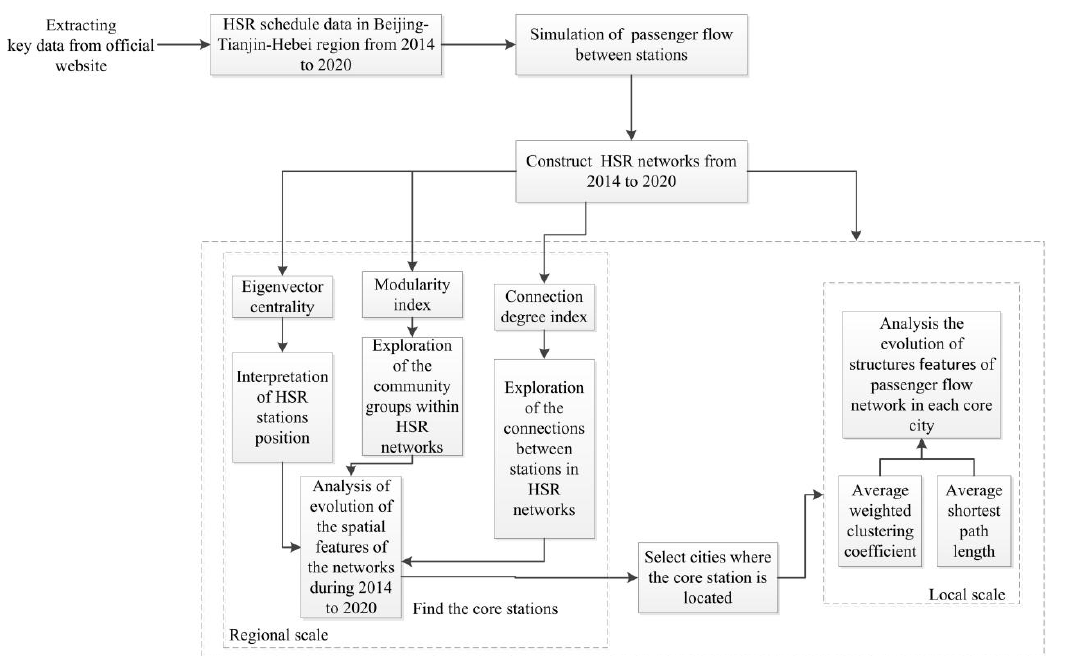
Figure 1. Research framework for this study.